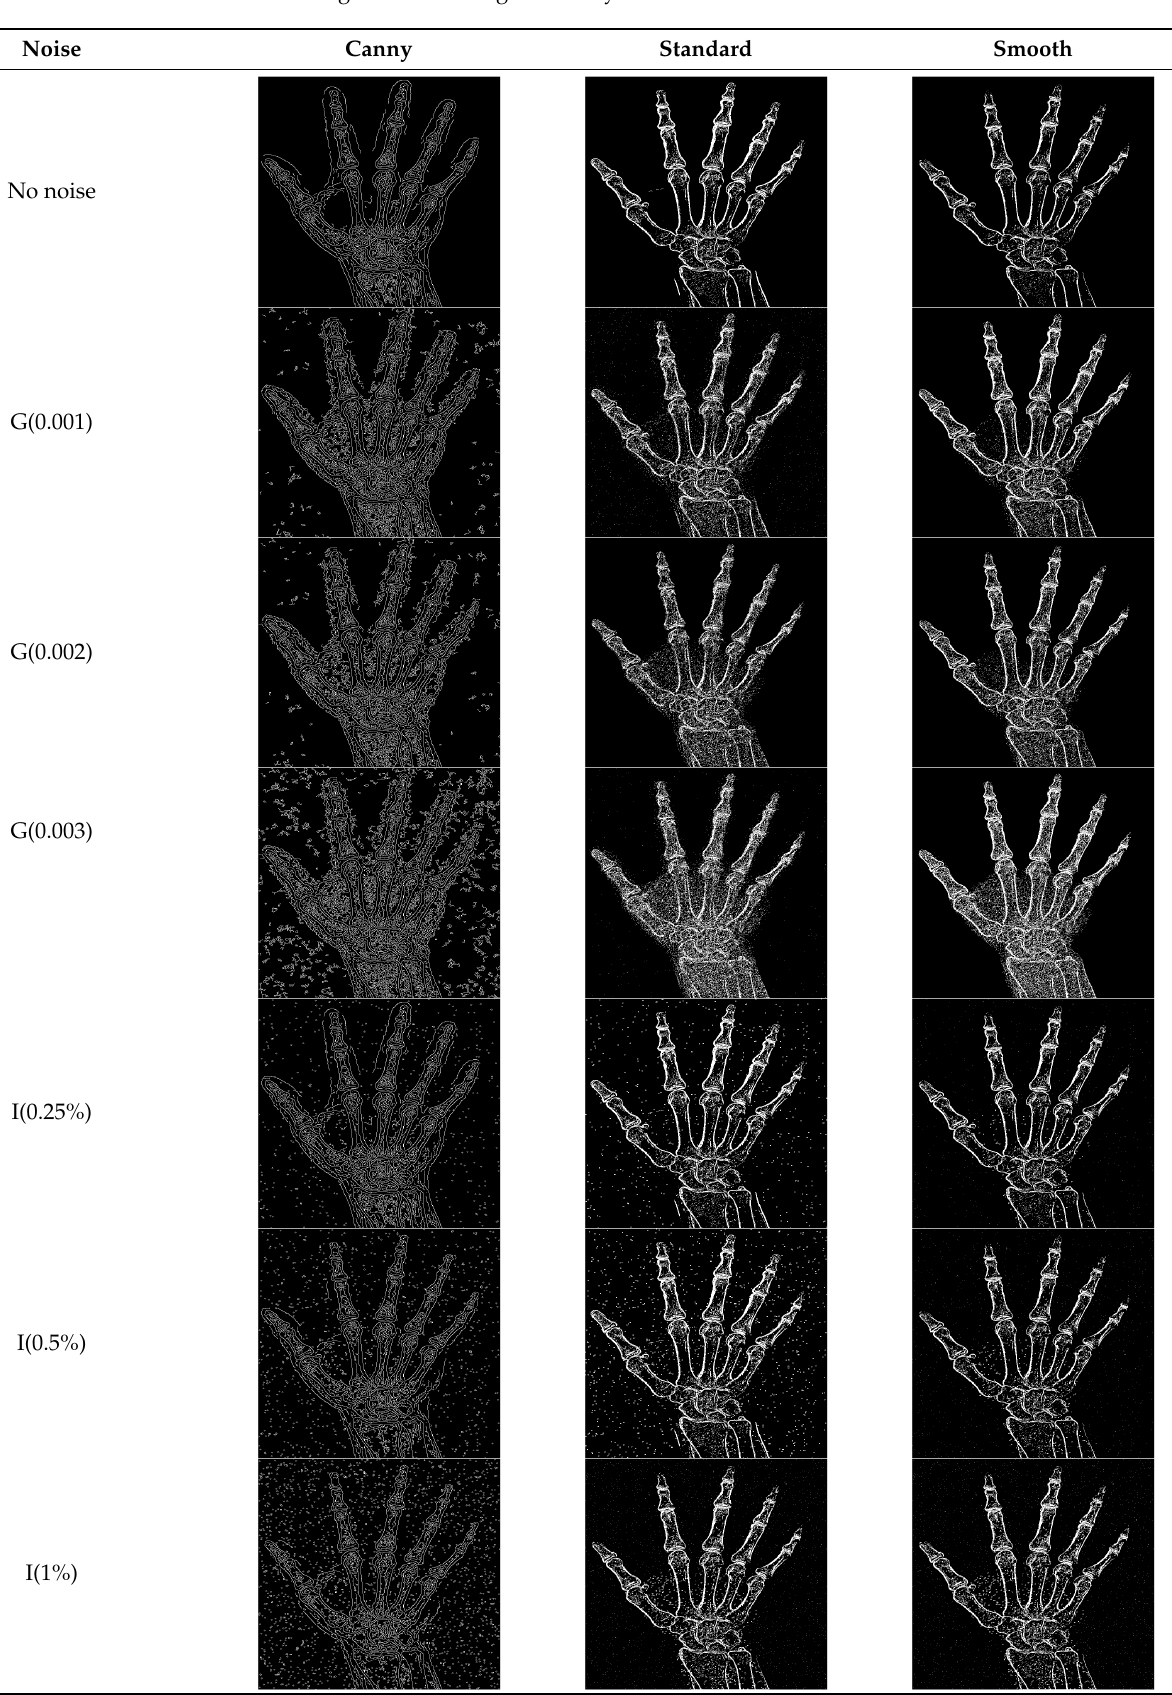
Table 11. Edge-detected image of “X-ray 2” after binarization for different